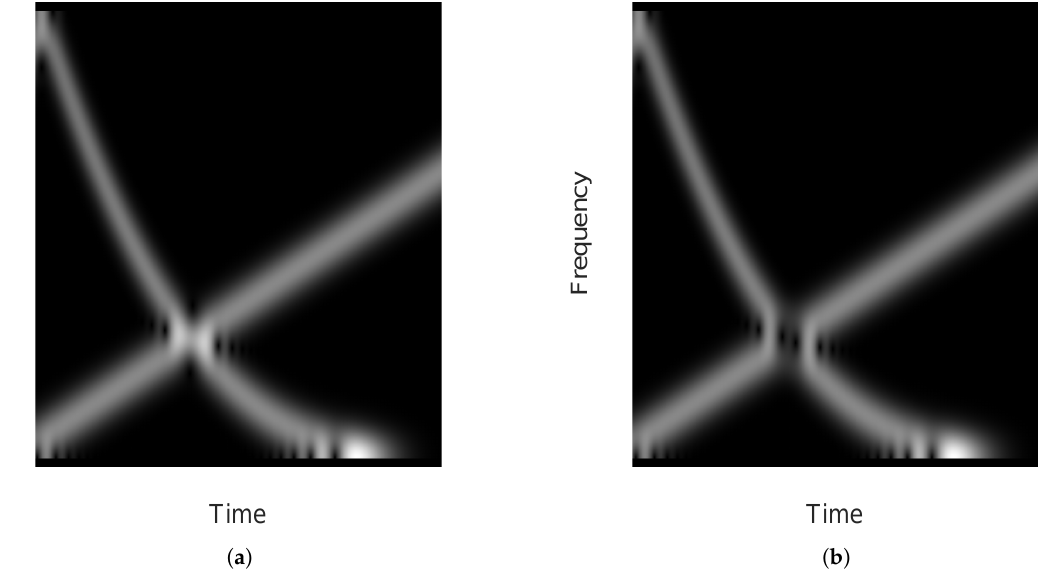
Figure 1. Two examples of spectrogram of an FM signal whose modes interfere with each other in the TF plane: ( a ) additive interference and ( b ) destructive